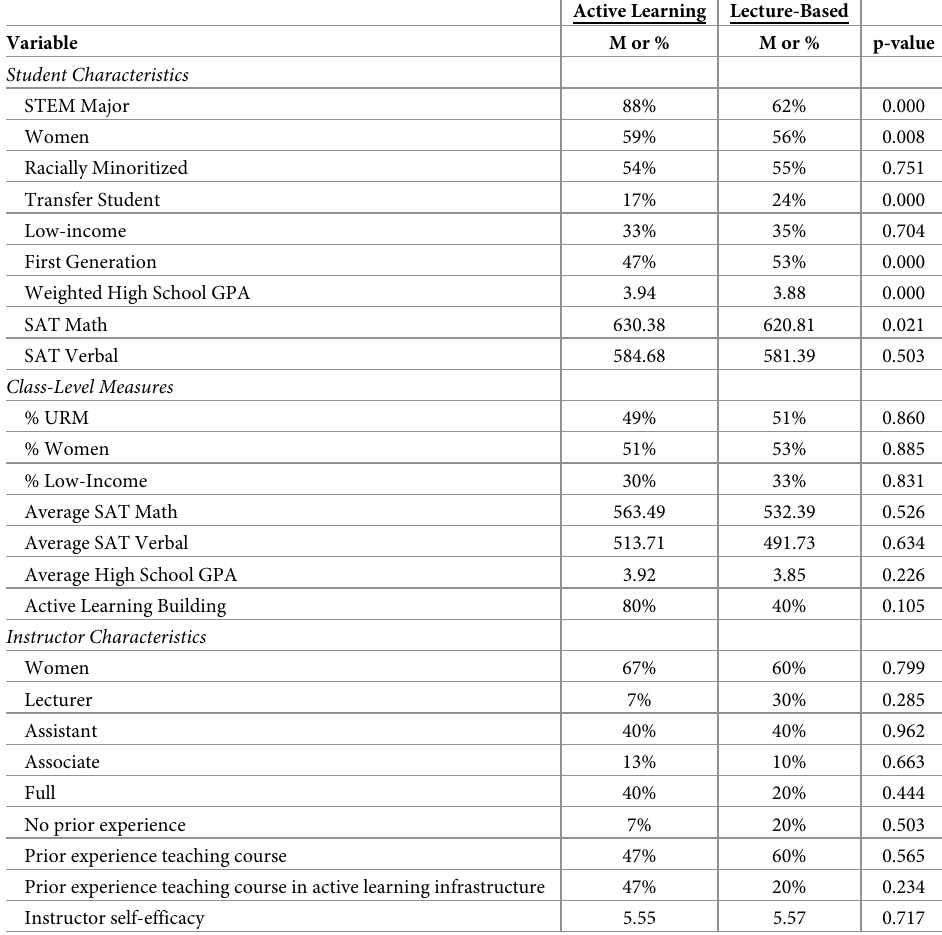
Table 2. Student characteristics and class